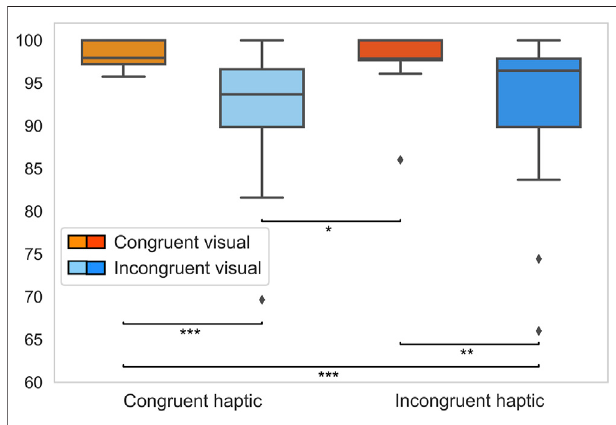
FIGURE 6 | Visual perception judgment accuracy across conditions (in percent).